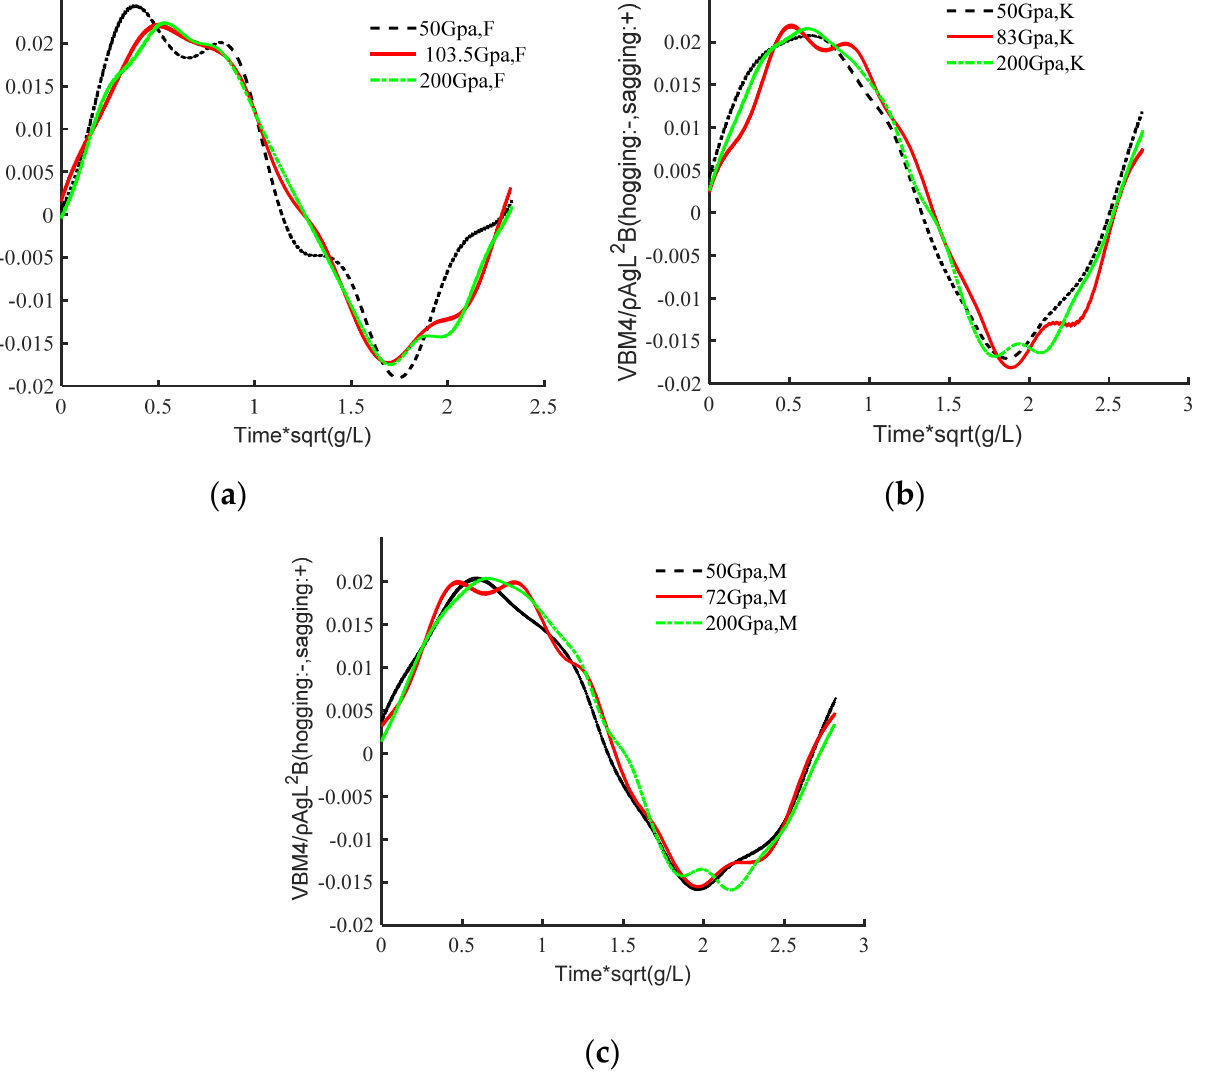
Table 5. Natural frequency of two-node vertical bending of different stiffness hull grides.